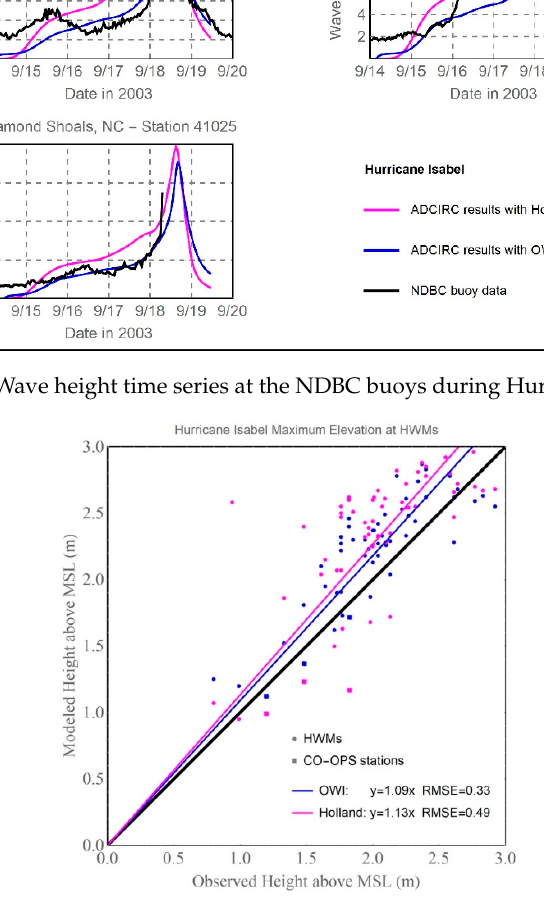
Figure 8. Scatter plot of modelled versus observed HWMs and NOS peak values.